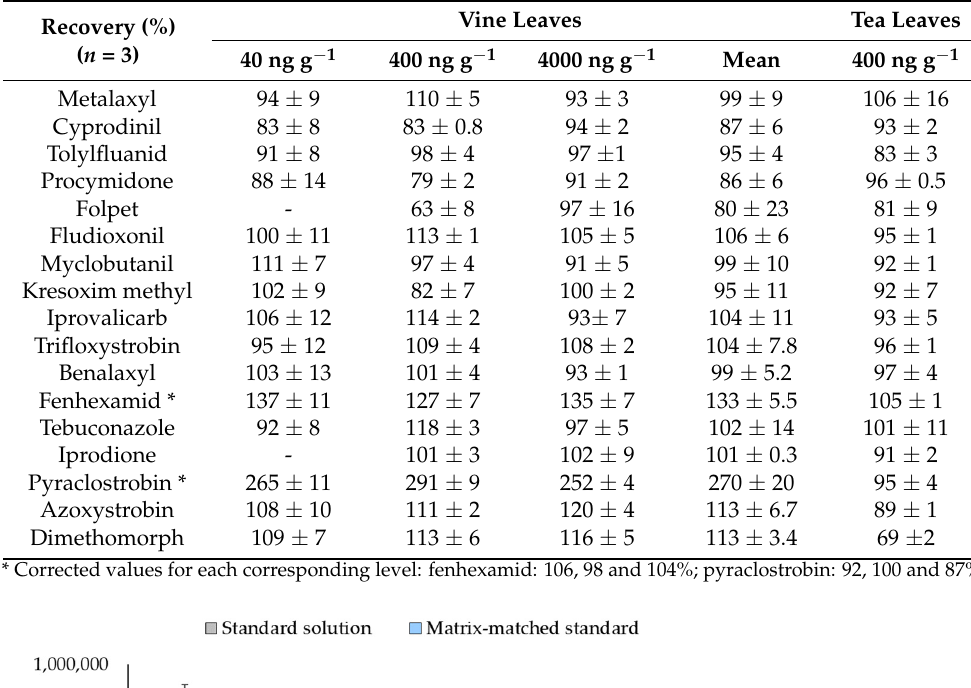
Table 2. Fungicide recoveries obtained for vine and tea leaves.